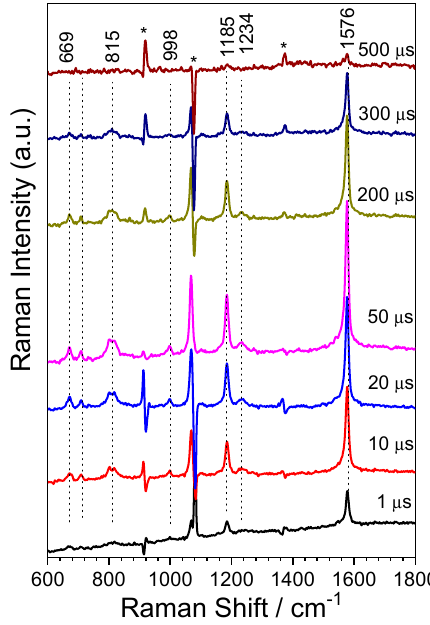
Figure 2. The ns-TR 3 spectra of 1 produced in 1:1 MeCN:HClO 4 (1 mM) acquired by pump 266 nm, probe 368.9 nm. The star symbols indicate the regions affected by solvent sub-traction artifacts.